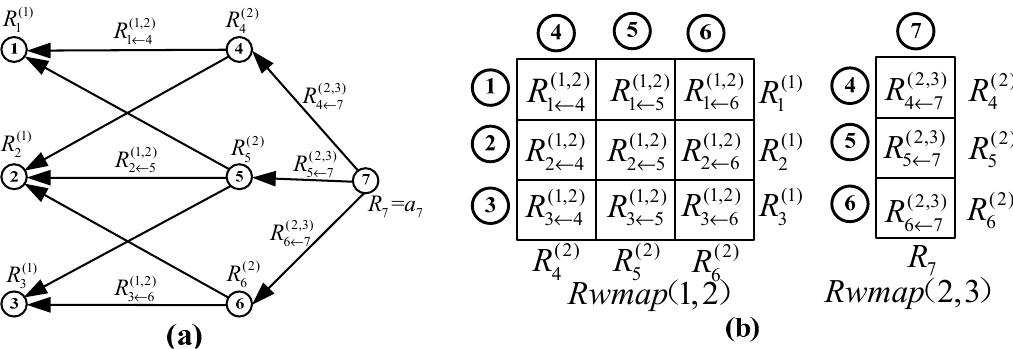
Figure 4. The Rw map schematic. ( a ) Network parameter LRP values graph. ( b ) Correspondence between pixels and LRP values.